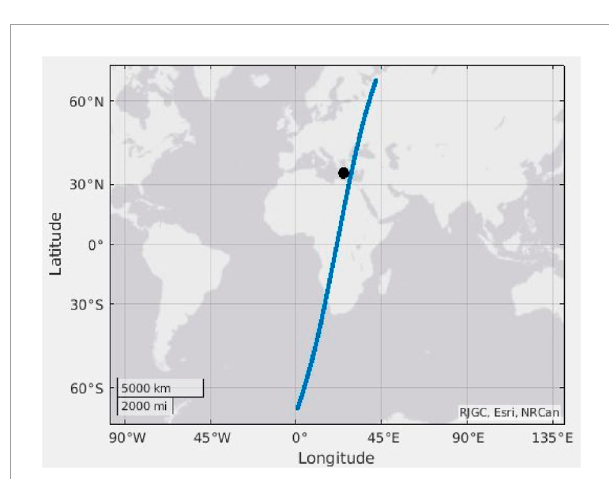
FIGURE 12 CSES-01 orbit (blue line) flying over the EE, 17 h before the earthquake. The black point represents the EE.